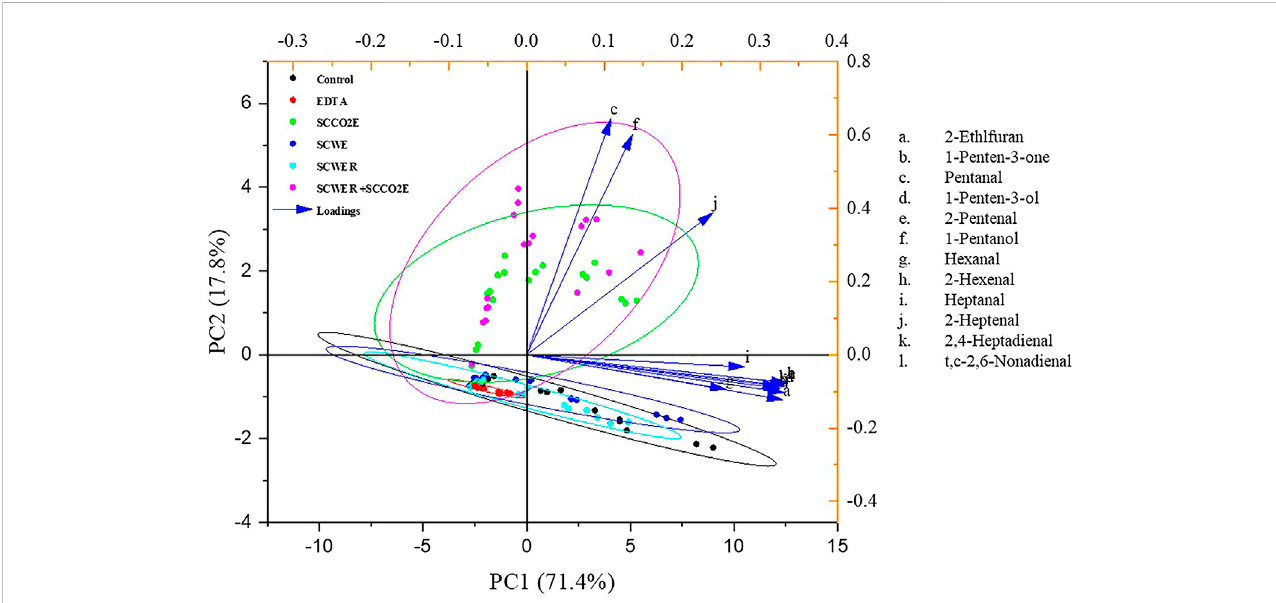
FIGURE 5 Principal component analysis (PCA) for the different volatile compounds. The blue arrows indicate the loadings. The different ellipse represents the con fi denceintervals oftheanalysis (95%).The arrow( → )shows theloadings ofdifferentvolatilesanalysed (2-ethlfuran,1-penten-3-one, Pentanal,1-penten- 3-ol, 2-pentenal, 1-pentanol, Hexanal, 2-hexenal, Heptanal, 2-heptenal, 2,4-heptadienal, t,c-2,6-nonadienal).